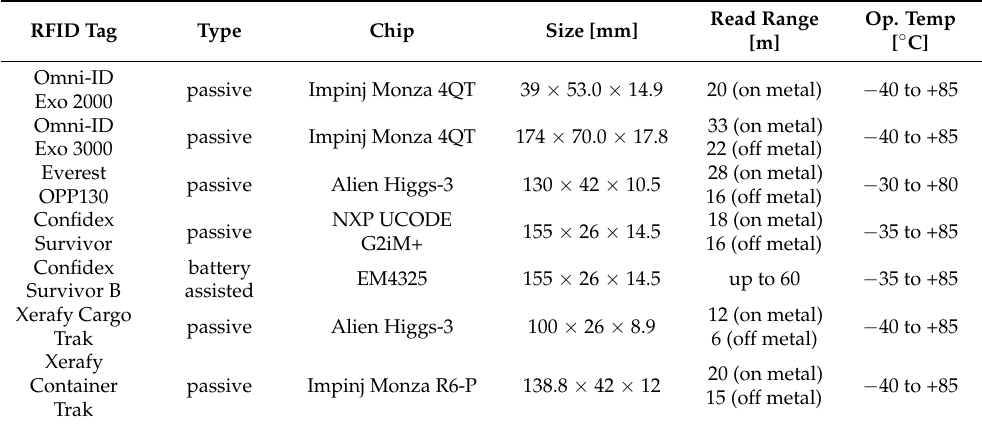
Table 5. UHF RFID reader with long read range and suitable for outdoor